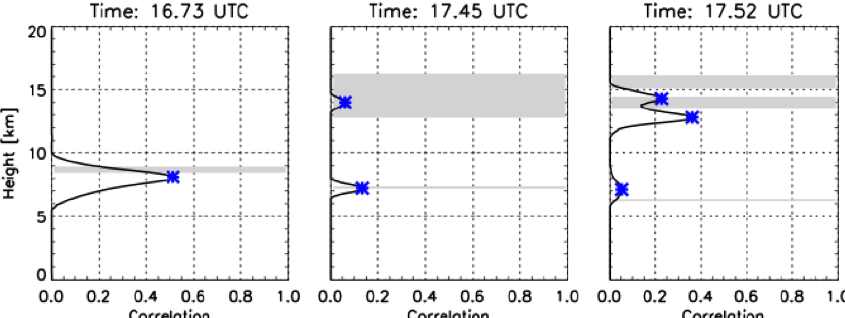
Figure 3. (a) A single-layer RSP correlation profile with the detected layer’s height shown as a blue star and the CPL-detected cloud boundaries shown in light grey. (b) Same as panel (a) but detailing a two-layer cloud profile. (c) Same as panel (a) but detailing a three-layer cloud profile. Data were obtained on 16 September 2013.